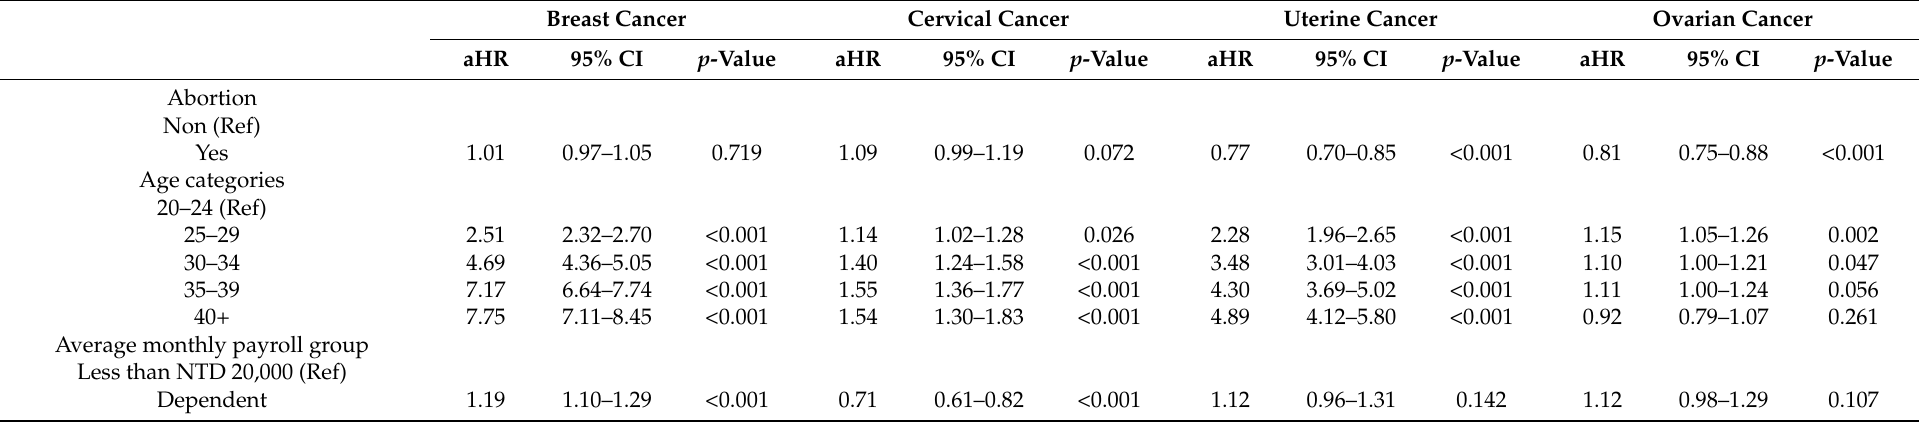
Table 3. Cox proportional hazard full models for female cancer outcomes between matched abortion and non-abortion cohorts. Breast Cancer Cervical Cancer Uterine Cancer Ovarian Cancer aHR 95% CI